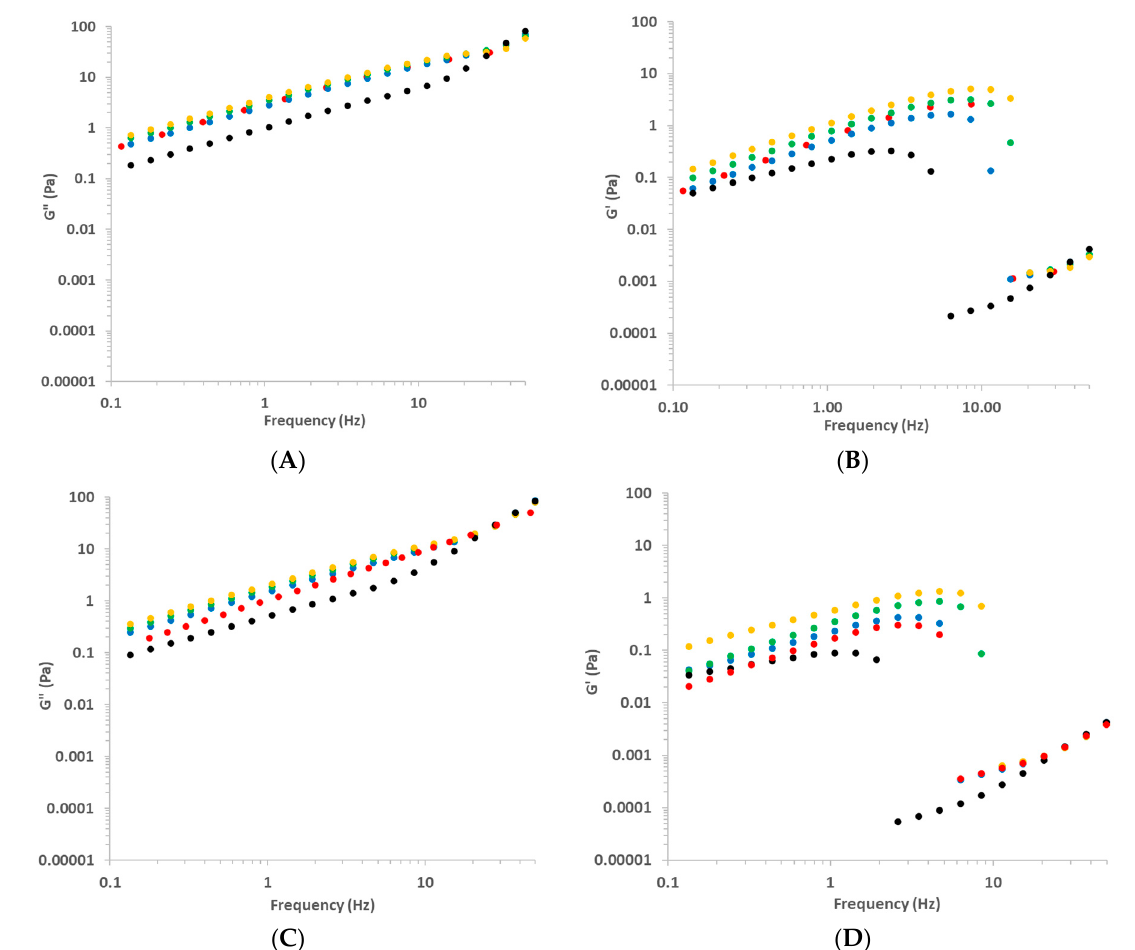
Figure 9. Loss (G”, A , C ) and storage (G’, B , D ) moduli determined by frequency sweep tests of chi- tosan solutions prepared with several acetic acid concentrations: 2.5 (red), 2.0 (blue), 1.5 (green), 1.0 (yellow); at 25 ( A , B ) and 45 °C ( C , D ).